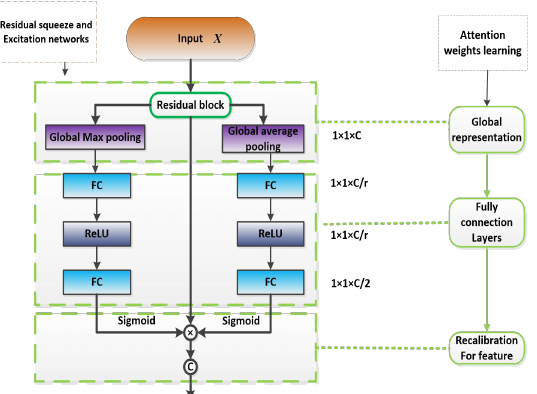
Figure 5 . The framework of proposed channel attention model. where f ijk is the value at position ( i, j, k ) of the feature map in the k -th channel. H and V are the length and width of the feature map, respectively. k f and k f are the feature value of GAP avg max and MAP, respectively. Attention weight parameters can be obtained by two layers of the fully connected neural network as formula (4) and